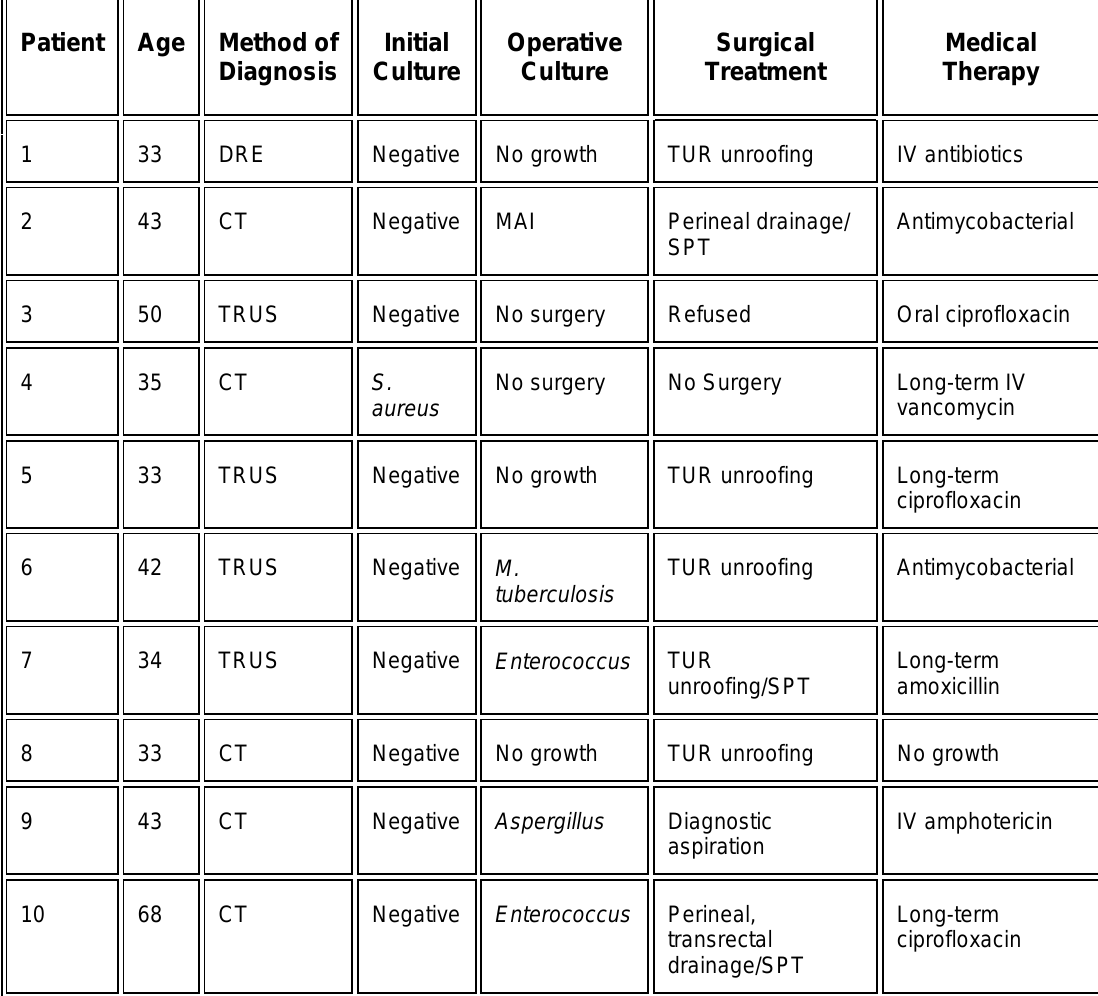
Diagnostic Modalities and Therapeutic Regimens in Ten Patients with Prostatic Abscesses.